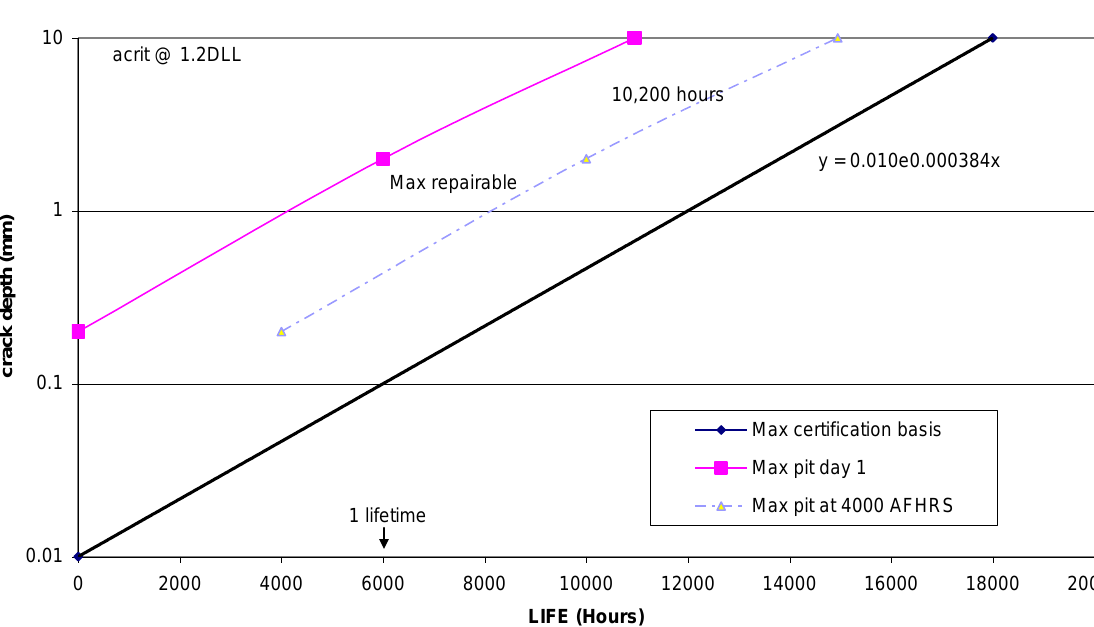
Figure 17. Schematic plots of the growth of (i) the most critical crack (—) in an optimised mean quality FSFT, assuming a fatigue-nucleating corrosion pit depth of 0.01 mm depth; and (ii) similar plots, i.e., with the same maximum growth rate, for a fatigue-nucleating corrosion pit depth of 0.2 mm.